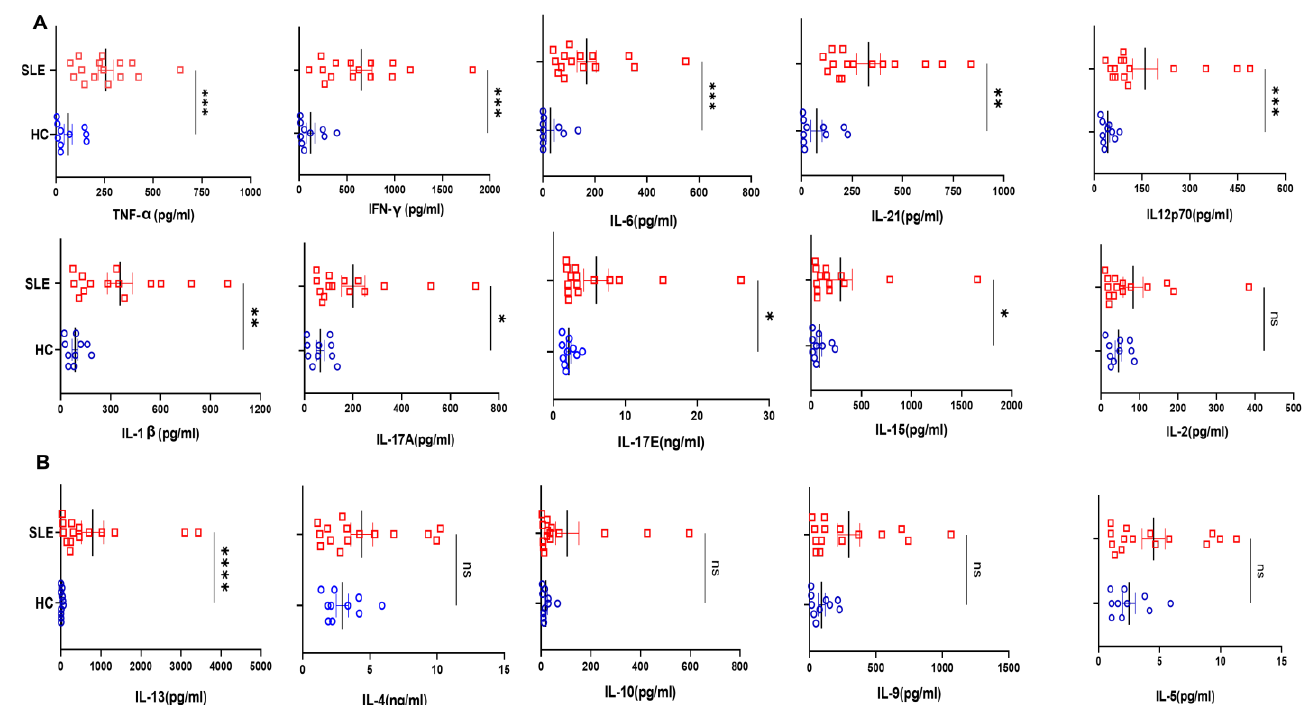
Figure 2. Cytokines analyses in SLE patients and healthy controls. Representative figures from 20 T cell cytokines analyzed in SLE patients’ plasma ( n = 15) and healthy controls ( n = 10) are represented as plunge plots. Inflammatory cytokines including IFN −γ, IL− 12p40, TNF −α, IL− 6, IL −1β, IL− 17A, IL − 17E, IL − 21, IL − 15 and IL − 21 were significantly elevated in SLE patients as compared to HC ( A ). Among anti-inflammatory cytokines, only IL − 13 was elevated in SLE patients, while all others, including IL − 10, IL − 4, IL − 5 and IL − 9, did not show any difference between the two groups ( B ). Error bar indicates SEM. Mann – Whitney U Test was performed to compare between the two groups; p < 0.05 was considered statistically significant (*); p < 0.01 was considered to be very significant (**); p < 0.001 was considered to be highly significant (***); p < 0.0001 was considered extremely significant (****), and ns means non-significant.